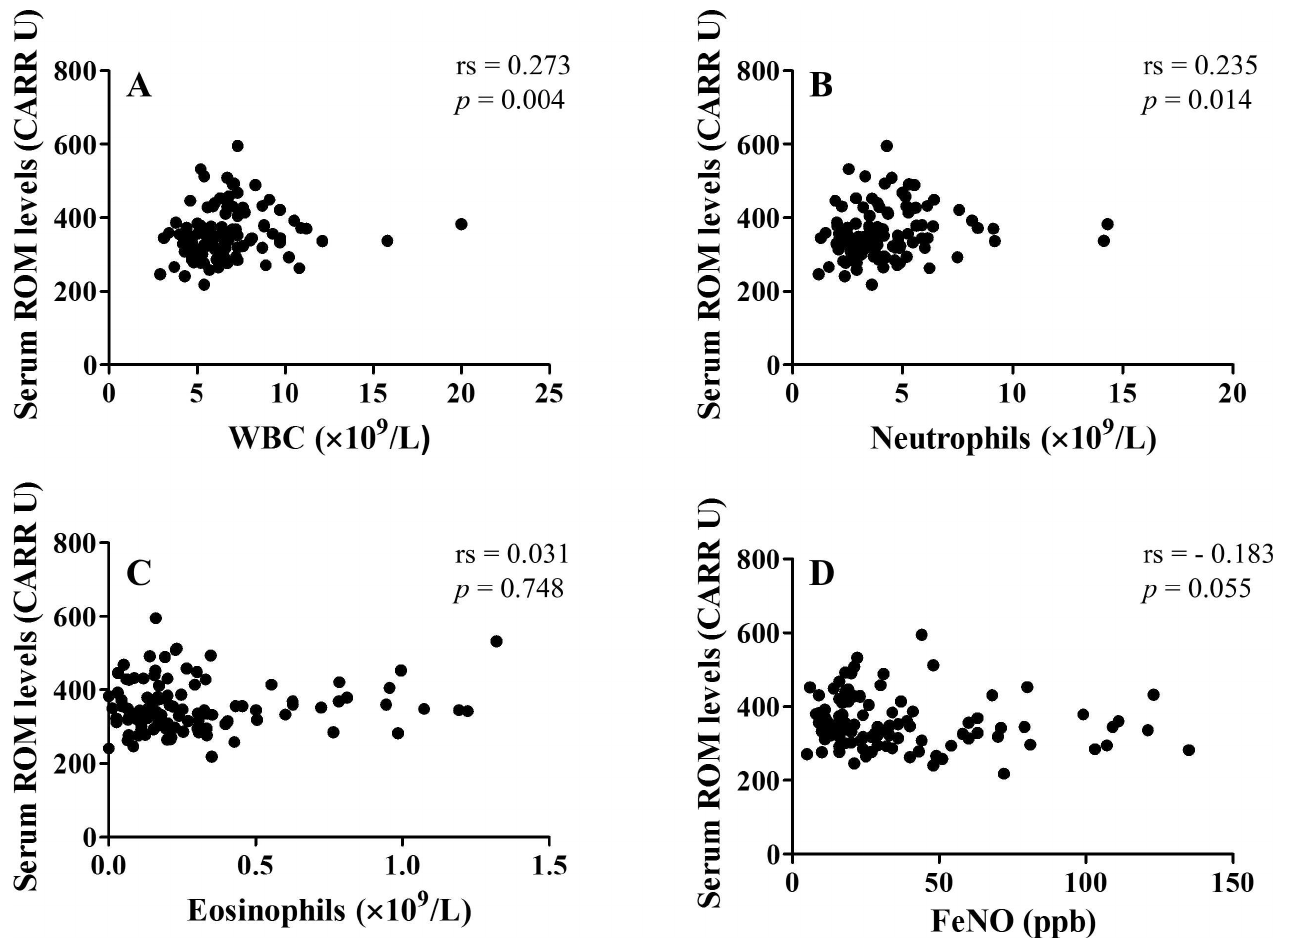
Fig 1. Correlation between serum reactive oxygen metabolite (ROM) levels and biomarkers. (A) Serum ROM levels and white blood cell (WBC) count. (B) Serum ROM levels and neutrophil count. (C) Serum ROM levels and eosinophil count. (D) Serum ROM levels and fractional exhalednitric oxide (FeNO).